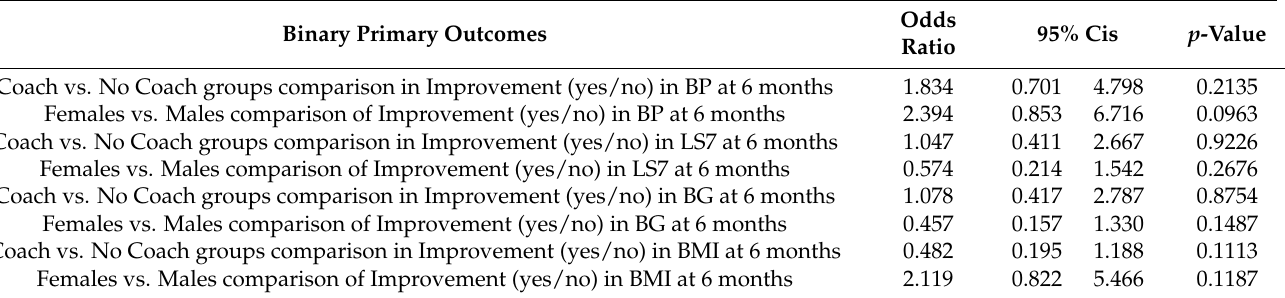
Table 4. GLMM multivariate adjusted analyses of binary